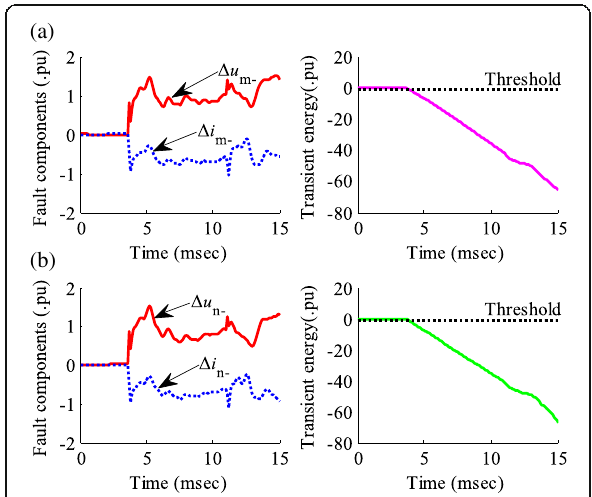
Fig. 11 Waveforms of fault components and transient energies detected on the negative pole line for a fault at F 3. a Rectifier station. b Inverter station